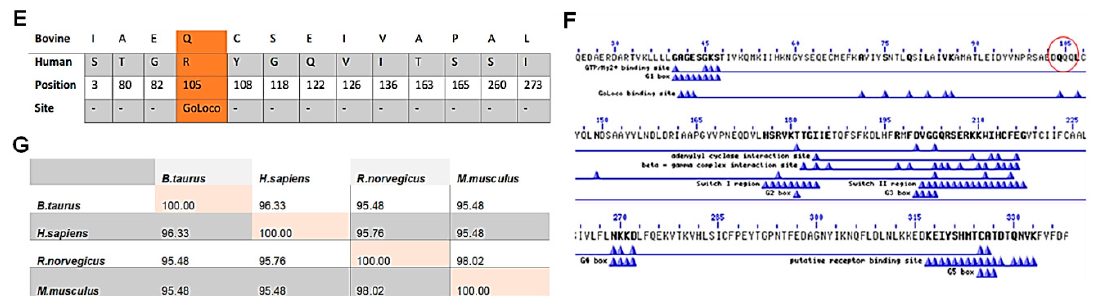
Figure 7. Preliminary data mining and bioinformatics studies on bovine α -gustducin. ( A ) Chromosomal mapping of the human and bovine type 2 taste receptor (T2R) gene family and GNAT-3 . ( B ) Bovine GNAT-3 gene location and neighbouring genes (i.e., CD36 —receptor for fat); ( C ) Ensembl gene splicing image showing one protein coding variant of GNAT-3 gene and its associated exons—in filled rectangles and introns—as lines in between; ( D ) multiple alignment sequences of bovine GNAT-3 compared to human, mouse and rat GNAT-3 amino acid sequences; red box—mutation in the aspartate-glutamine- arginine triad (i.e., DQR); ( E ) altered amino acid residues found in the bovine protein compared to human GNAT-3 protein and associated functional site; ( F ) graphical summary of GNAT-3 conserved domains with its several functional features; red encircle amino acid sequences represents the DQQ <> DQR triad sequences; and ( G ) bovine GNAT-3 protein percent identity matrix compared to that of humans and rodent